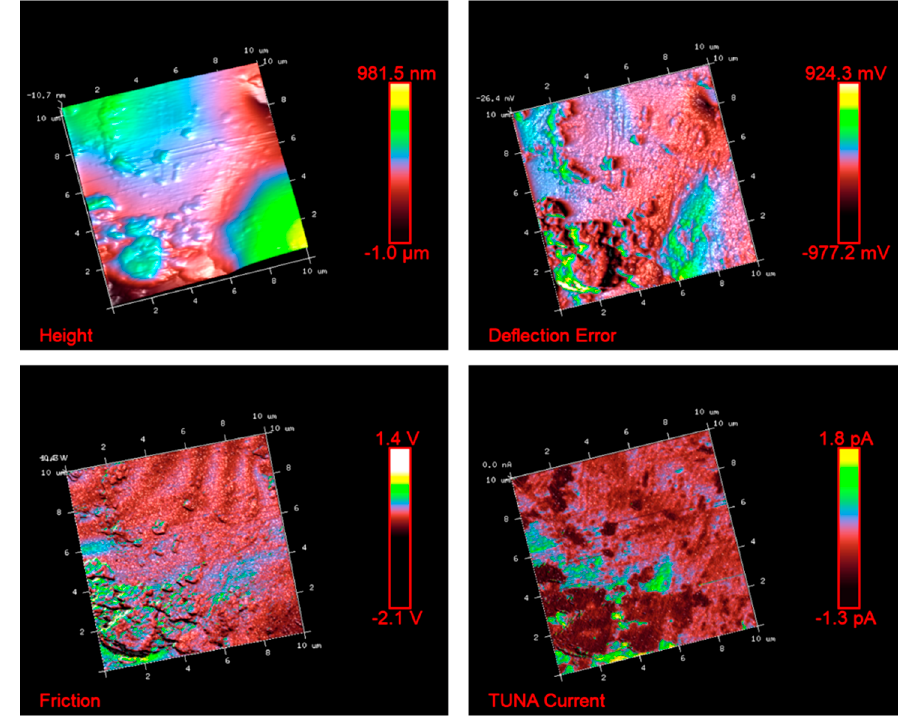
Figure 6. TUNA pictures of the 3D shapes (corresponding to the images reported in Figure 5) of the R0.1%G-py fracture surface. Nanomaterials 2020 , 10 , x FOR PEER REVIEW